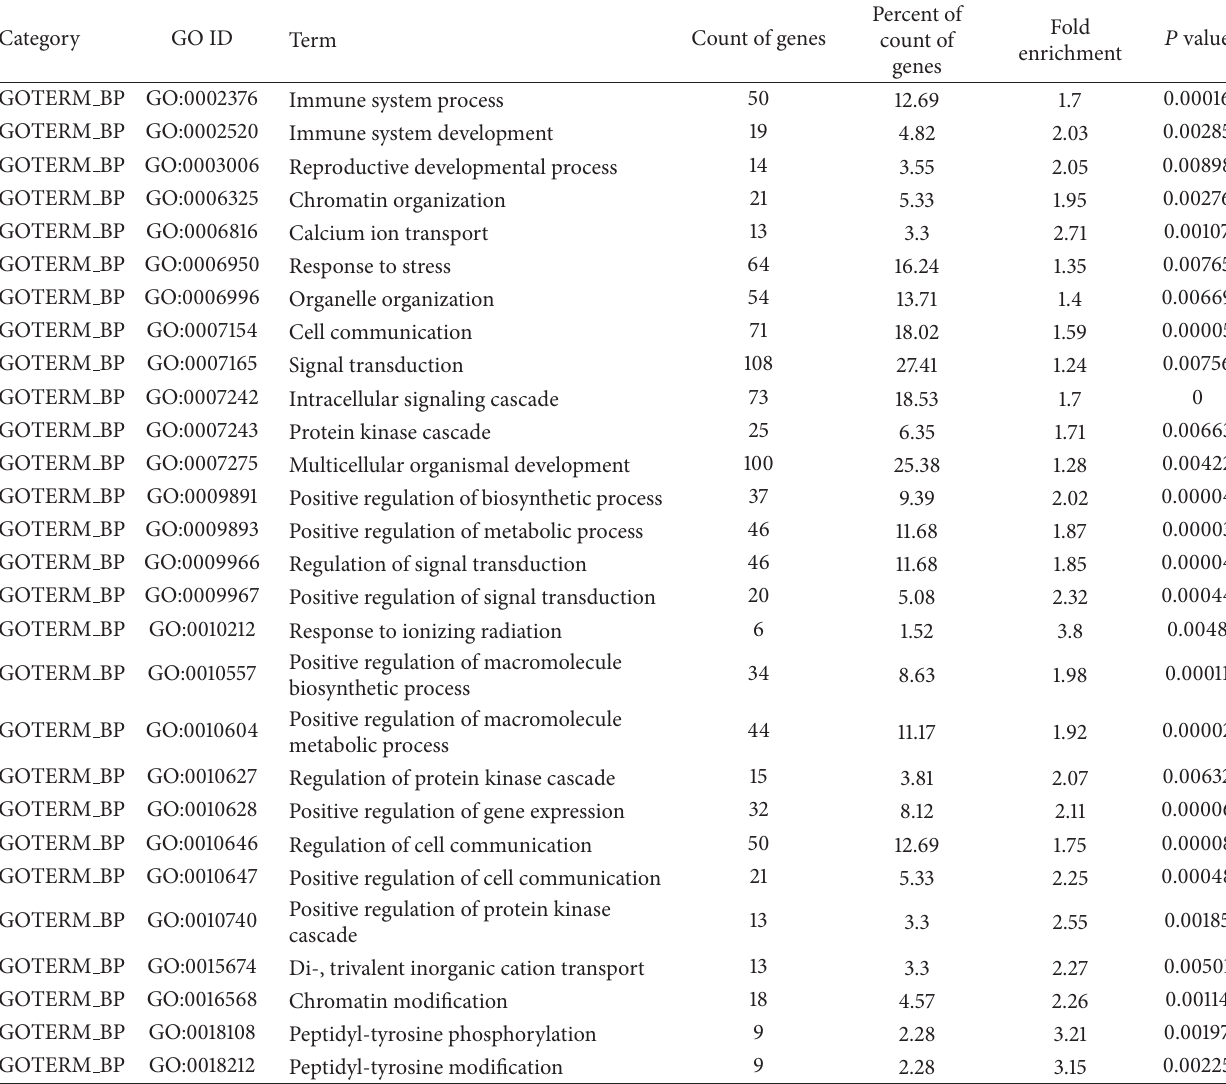
Table 2: GO analysis of ankylosing spondylitis with different biological processes related to